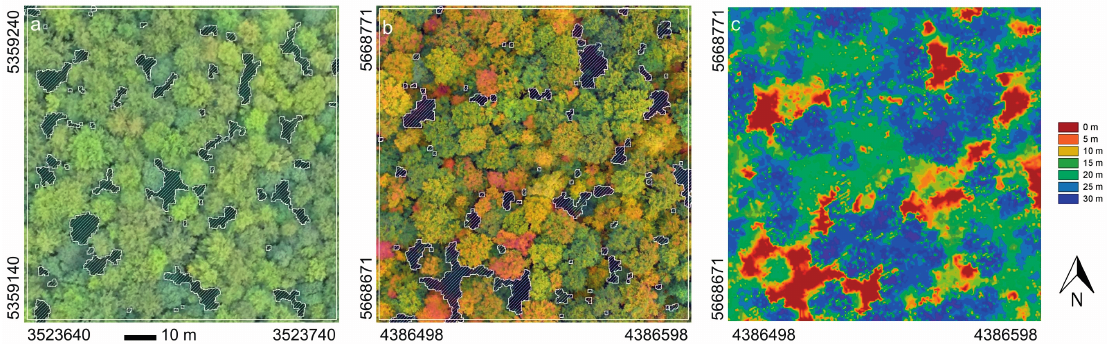
managed age-class beech forest of the Schwäbische Alb ( a ). Shown are the delineated gaps, which range in size from 81.7 m 2 to 1.1 m 2 . The image was taken on 2 September 2009. UAV image of the plot HEW31, a selection-cutting forest in the Hainich ( b ). Colors are more intense, since the image was taken later in the season on 8 October 2008. Shown are the segmented gaps whose spatial structure closely resembles the gaps of the same plot, HEW31, mapped in August of the same year with a manned LIDAR flight ( c ). The legend on the right is based on the z-coordinate for the uppermost surface measured with